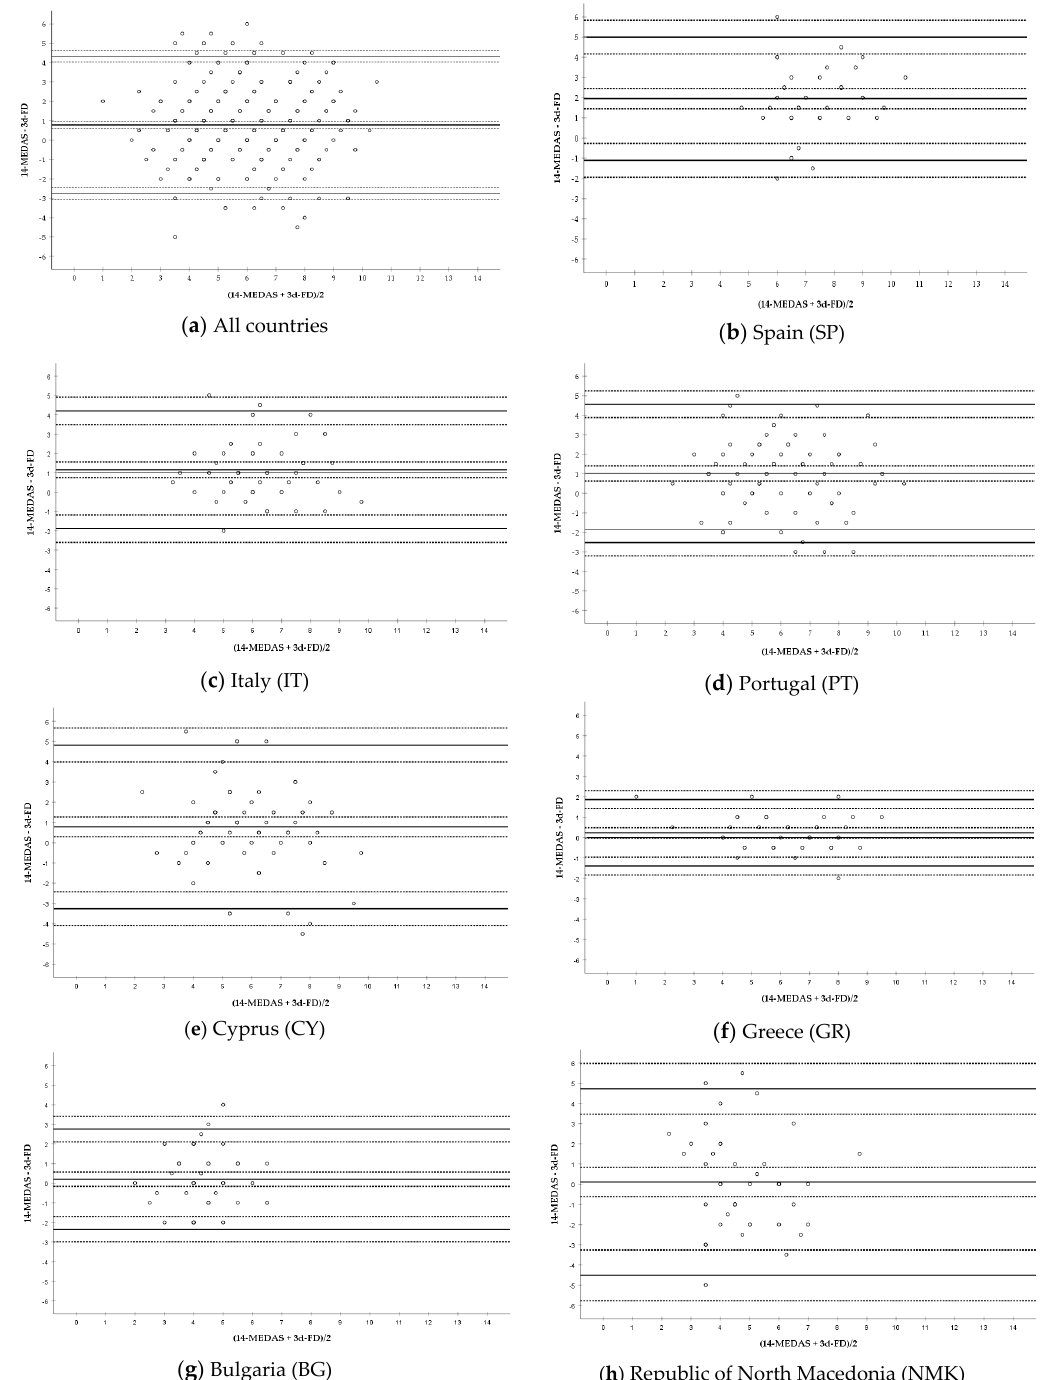
Figure 1. Bland–Altman plots of the differences between the results of the 14-MEDAS questionnaire and those of the 3d-FD. Y axis: DIFFERENCE (14-MEDAS—3d-FD) vs. X axis: MEAN ((14-MEDAS + 3d-FD)/2). Results are presented for: (a) All countries together, (b) Spain (SP), (c) Italy (IT), (d) Portugal (PT), (e) Cyprus (CY), (f) Greece (GR), (g) Bulgaria (BG), (h) Republic of North Macedonia (NMK).